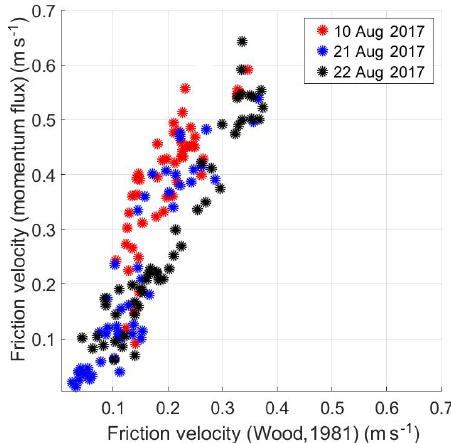
Figure 1. Comparison of the friction velocities obtained from the momentum flux and the Wood (1981) approaches for different days with different wind speeds (average wind speeds of 2.9, 2.1 and 3.1ms − 1 for 10, 21 and 22 August 2017,